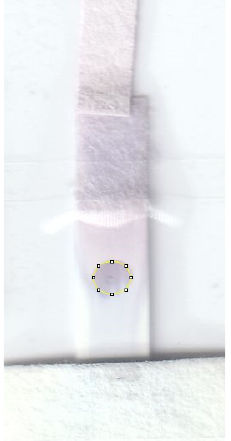
Figure 6. Detection zones showing the color that forms in the nitrocellulose. The region of interest, depicted as a yellow circle with a diameter of approximately 2 mm, is used to determine the color intensity by using ImageJ software.